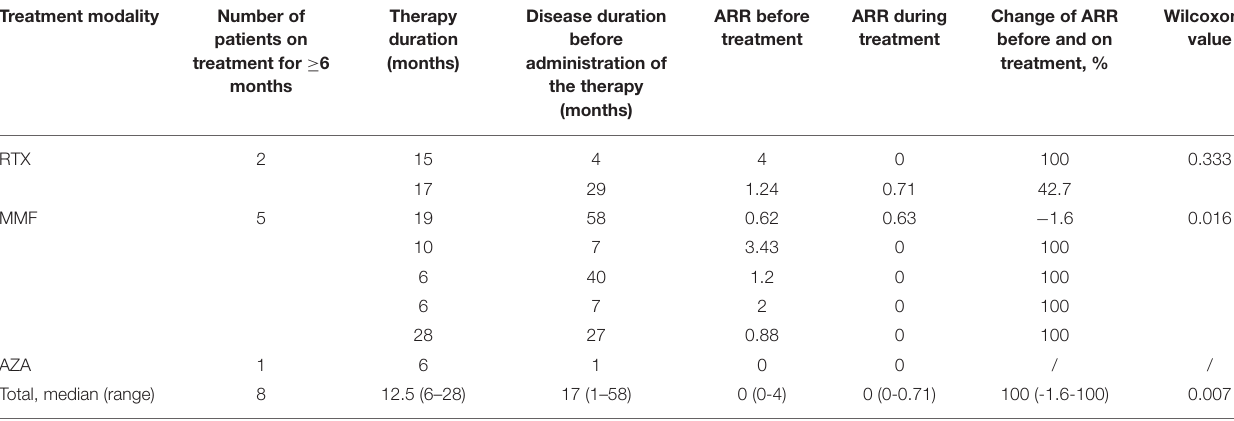
TABLE 4 | Efficacy of other immunosuppressive agents in MOG-ab-positive children.